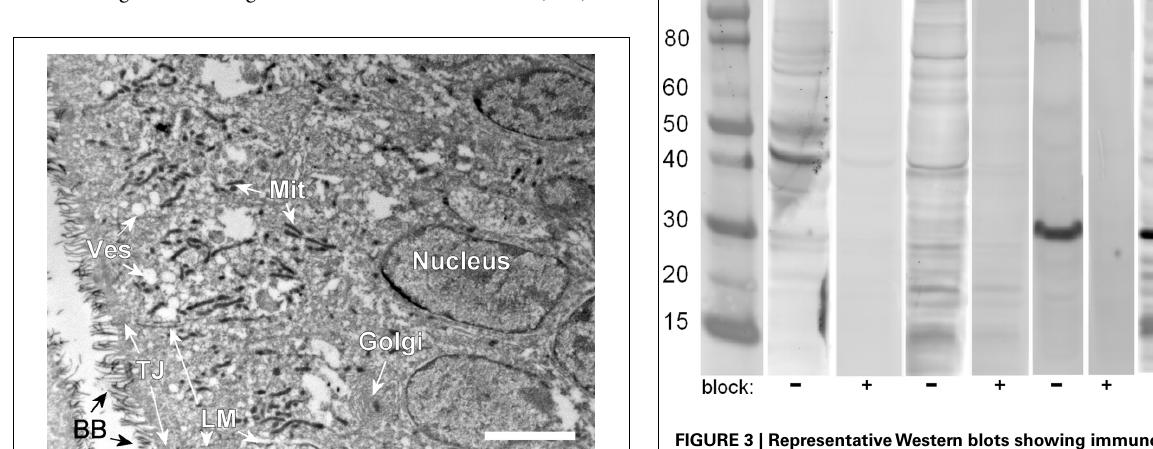
FIGURE 3 | RepresentativeWestern blots showing immunoreactive bands using homologous, affinity purified antibodies againstAqp1aa (lanes 2–5),Aqp1ab (lanes 6–7) andAqp8ab (lanes 8–9) in homogenates from pyloric caeca (lanes 4–9), or kidney (lanes 2–3) from SWAtlantic salmon. In lanes 3, 5, 7, and 9, where the antibodies were preadsorbed with 400 × molar excess of the respective immunizing peptide, the band intensities were much reduced. Molecular weight markers of the indicated sizes (MwM, in kDa) are shown in lane